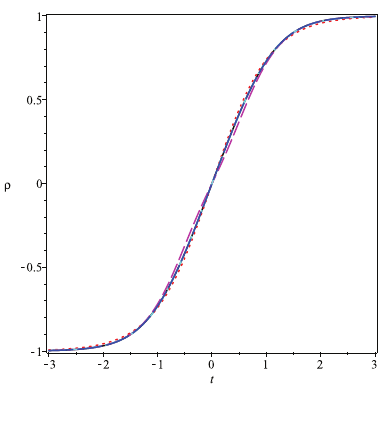
Figure 2. Comparison of various approximations of the heteroclinic solution to the exact solution (solid black line) for ω = σ = 1 . The red dotted, magenta dashed, cyan dash-dotted and blue long-dashed lines correspond to Eq. (3.12), Eqs. (3.13), Eqs. (3.14), and Eq. (3.15) respectively. Only the first two approximates can be distinguished at the scale of the